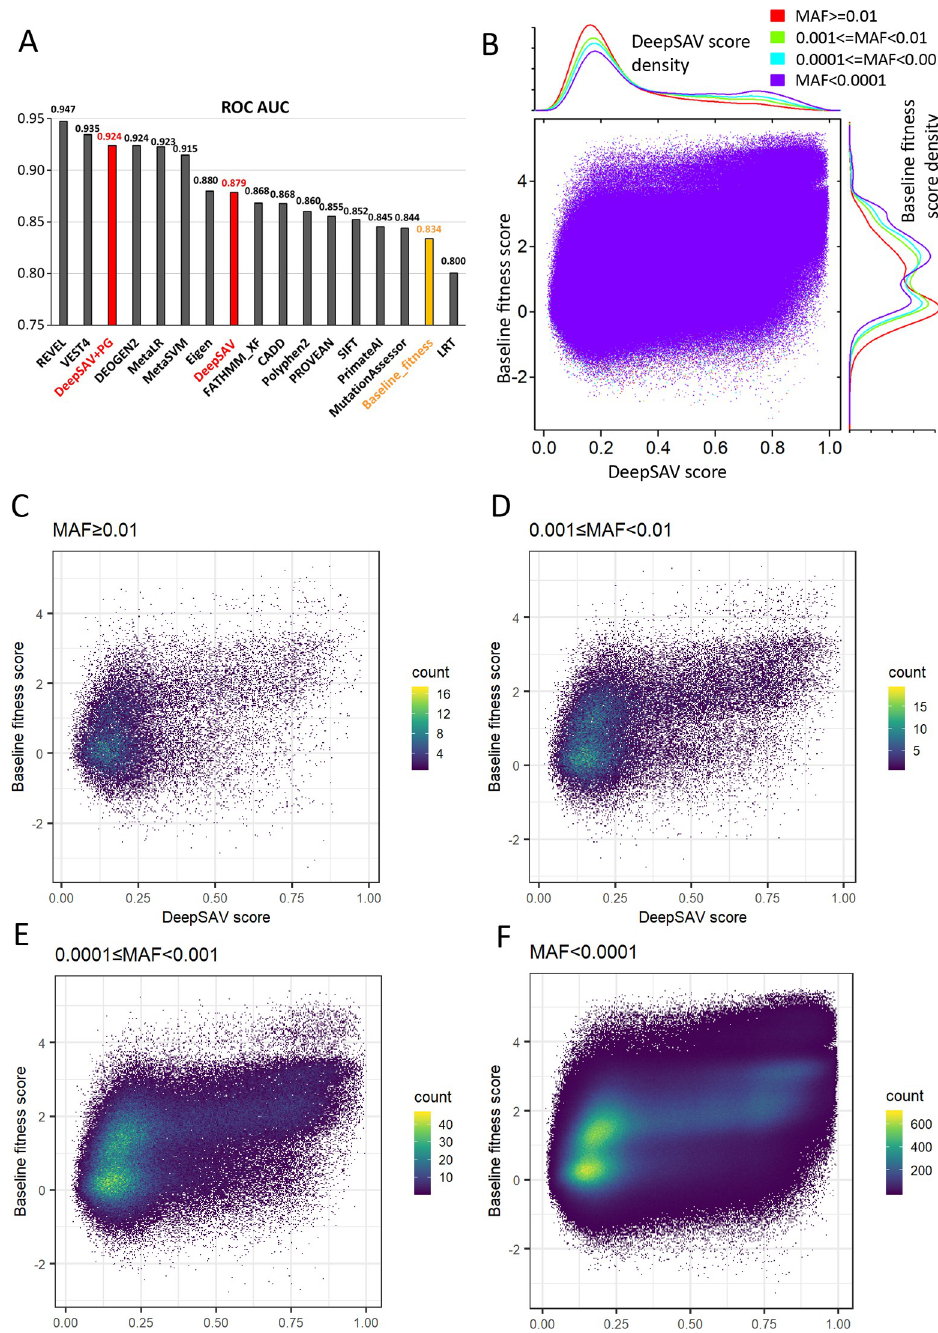
Fig 3. A) Performance of variant pathogenicity prediction programs in terms of AUC (area under the ROC curve) measure. B) Scatter plot of DeepSAV scores and baseline fitness scores for SAVs observed in gnomAD. Datapoints for four different MAF categories are shown. Their density plots are shown by the axes above (DeepSAV) and right (baseline fitness). C) to F) Two-dimensional histograms (made with R ggplot2 package) of DeepSAV scores and baseline fitness scores for gnomAD variants with MAF � 0.01 ( C ), 0.001 � MAF < 0.01 ( D ), 0.0001 � MAF < 0.001 ( E ), and MAF < 0.0001 ( F ).